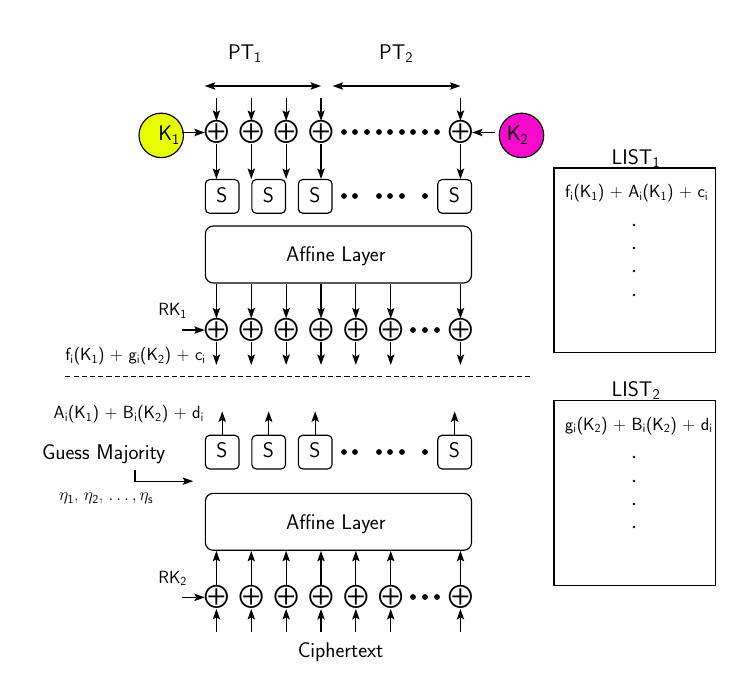
Figure 2: Meet in the